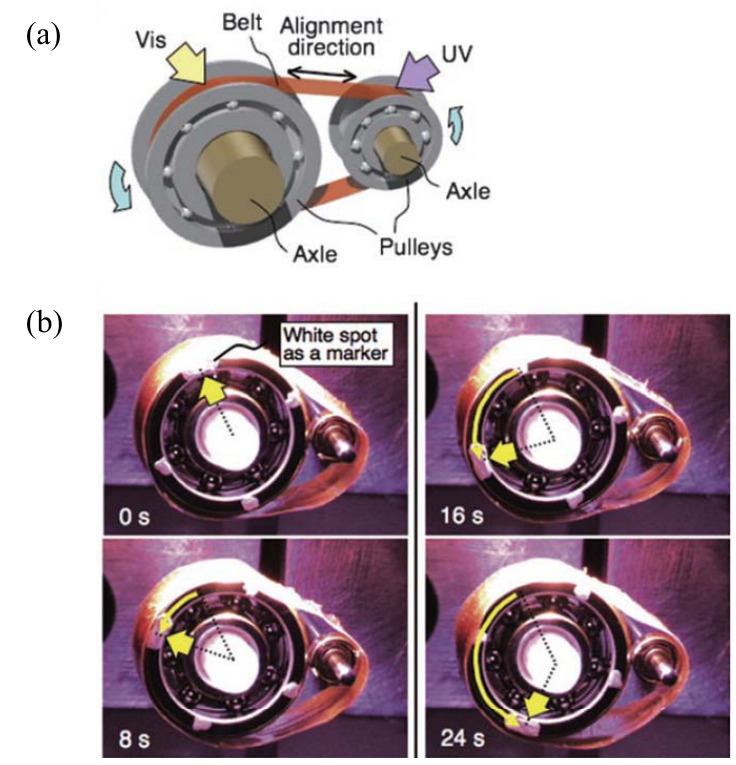
Figure 19. A photo-driven plastic motor with the laminated LCN film. ( a ) Schematic representation of the photo-driven plastic motor setup, ( b ) photographs of motor operation, upon irradiation with UV light on one side, the film contracts and irradiation with visible light from the other results in expansion, which results in the rotation of motor. Reprinted with permission [87]. Copyright Wiley-VCH